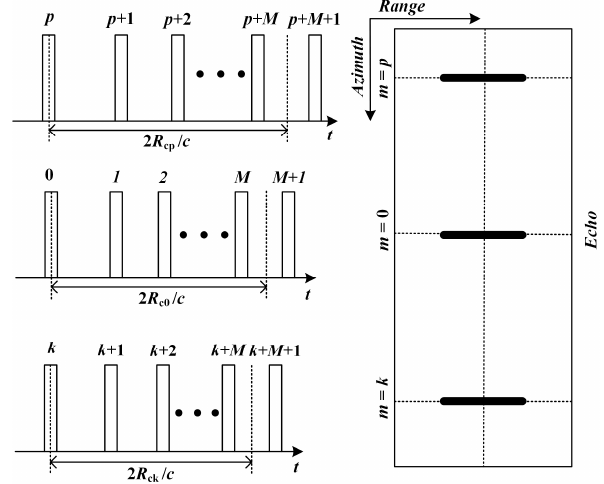
Figure 3. Expected Continuous Varying Pulse Interval (CVPI) based echo distribution.